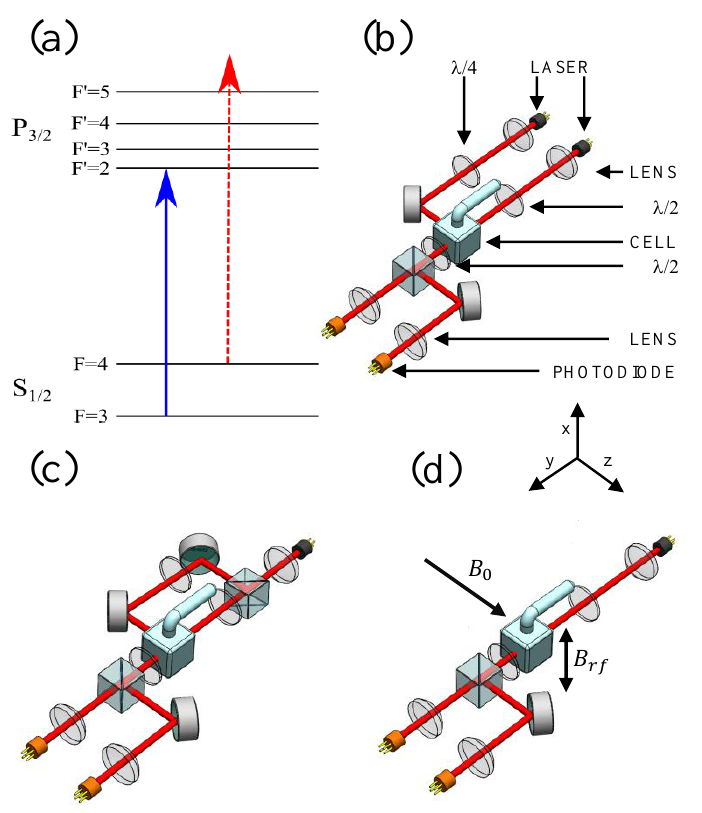
Figure 1. ( a ) Energy structure of cesium 6 2 S 1/2 → 6 2 P 3/2 transition (D2 line, 852 nm). The solid blue arrow represents the frequency of the pump beam, while the dashed red arrow represent the relevant frequency of the probe laser used in the independent pump and probe configuration. There are three possible configurations of the radio-frequency atomic magnetometer: ( b ) A circularly-polarised laser light (pump), tuned to the F = 3 → F’ = 2 transition propagating along ˆ z , transfers atoms into the stretched state of the F = 4 ground state level. The probe beam, propagating along ˆ y , monitors the spin precession via the paramagnetic Faraday effect. Both beams are at the same frequency, blue detuned 1GHz from the F = 4 → F’ = 5 transition (D2 line). ( c ) A single beam is split into a circularly polarised beam propagating along the ˆ z axis, and a linearly polarised beam propagating along ˆ y is used to create the population imbalance within the F = 4 caesium ground state manifolds. The linearly polarised beam acts also as a probe. ( d ) A linearly polarised laser beam, acting as the pump, transfers the population between and creates a population imbalance within the F = 4 caesium ground state manifolds. The same linearly polarised laser beam acts as the